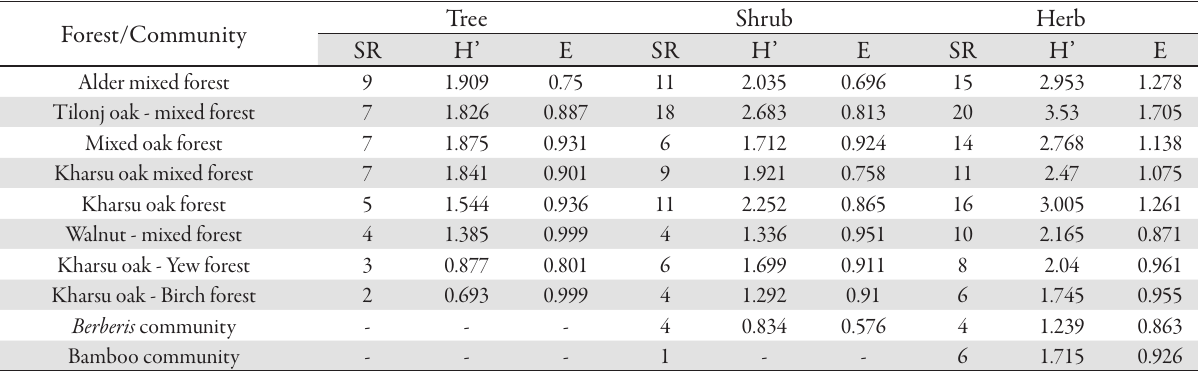
Tab. 3. Species richness (SR), diversity (H’) and evenness (E) of tree, shrub and herb layers in different